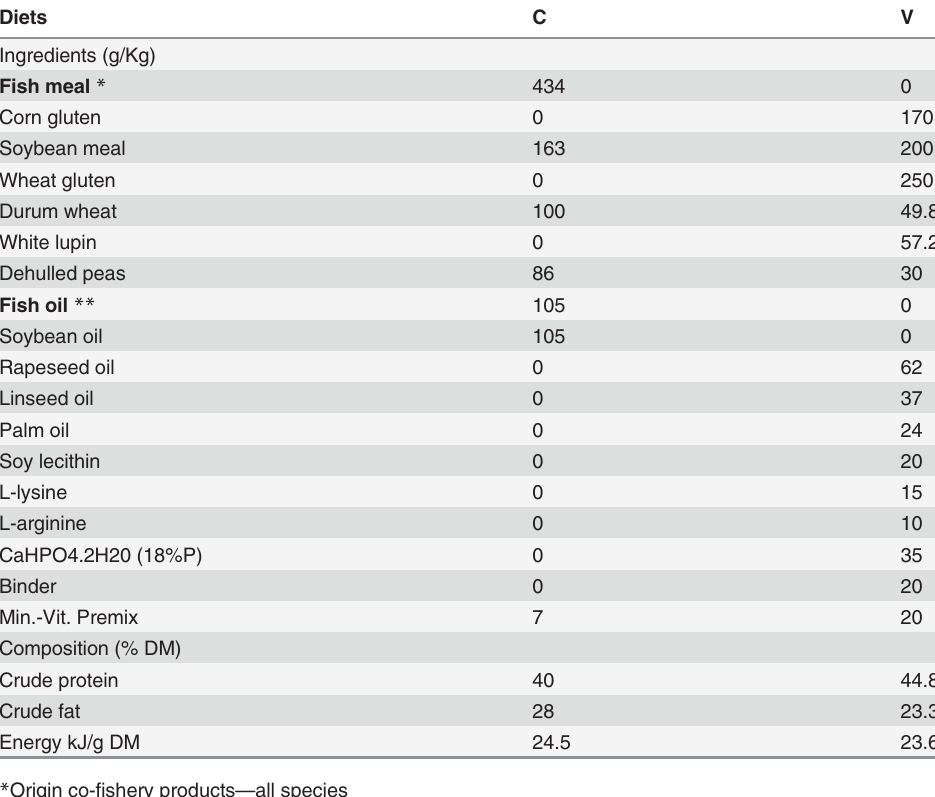
Table 1. Ingredients and composition of diets. Diets C V Ingredients